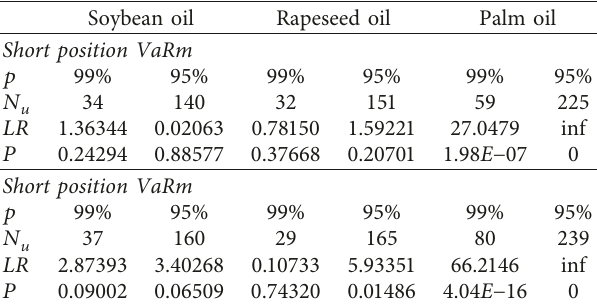
Table 11: VaR m backtesting results. Soybean oil Rapeseed